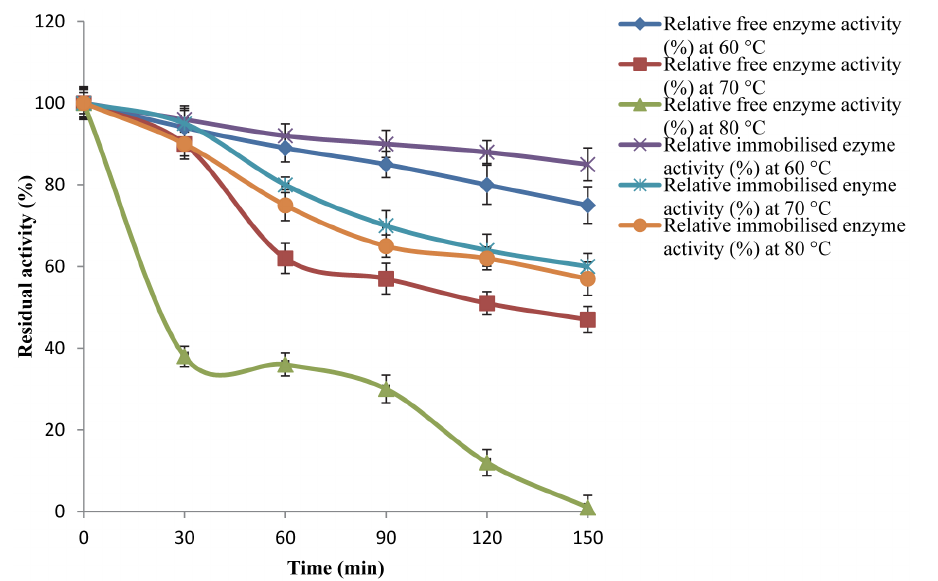
Figure 7. Thermostability studies of free and the immobilised lipase. Footnote: The lipolytic activity was determined following the method of Winkler and Stuckmann [21], using p-NP palmitate as substrate. Bars indicate the standard deviation from triplicate determinations.